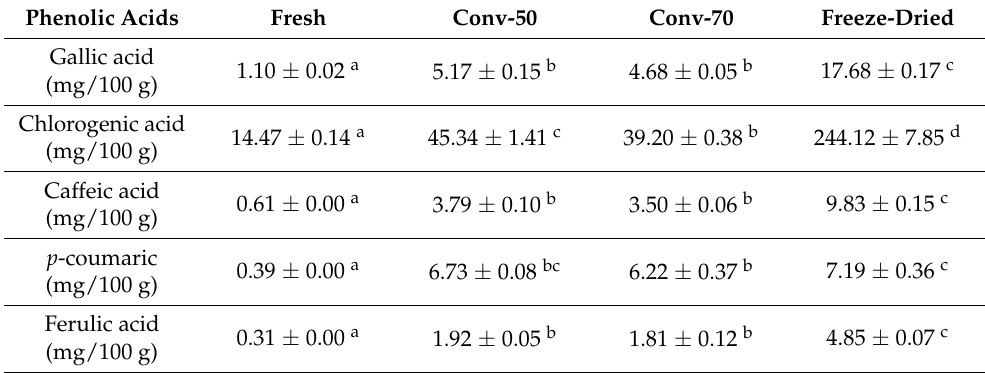
Table 5. The content of selected phenolic acids in fresh and dried quince fruit. Phenolic Acids